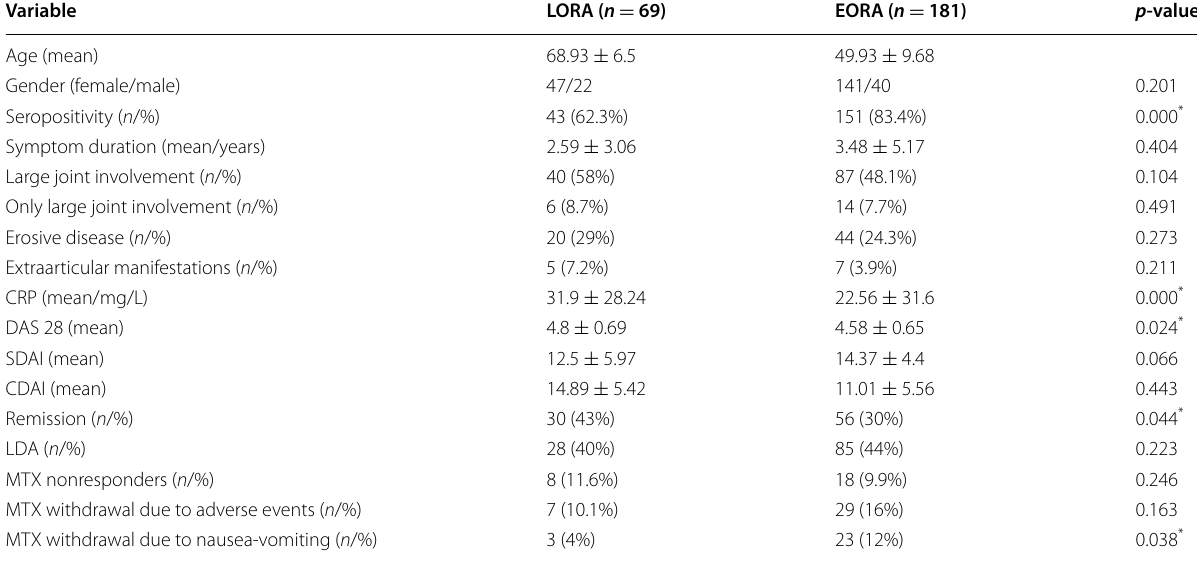
Table 3 Comparison of LORA and YORA